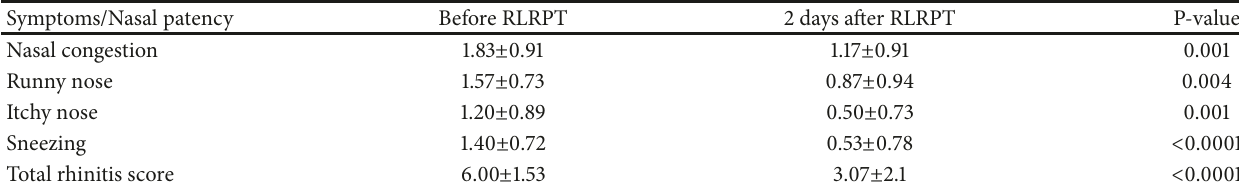
Table 2: Comparison before and 2 days after red light rhinophototherapy (RLRPT).